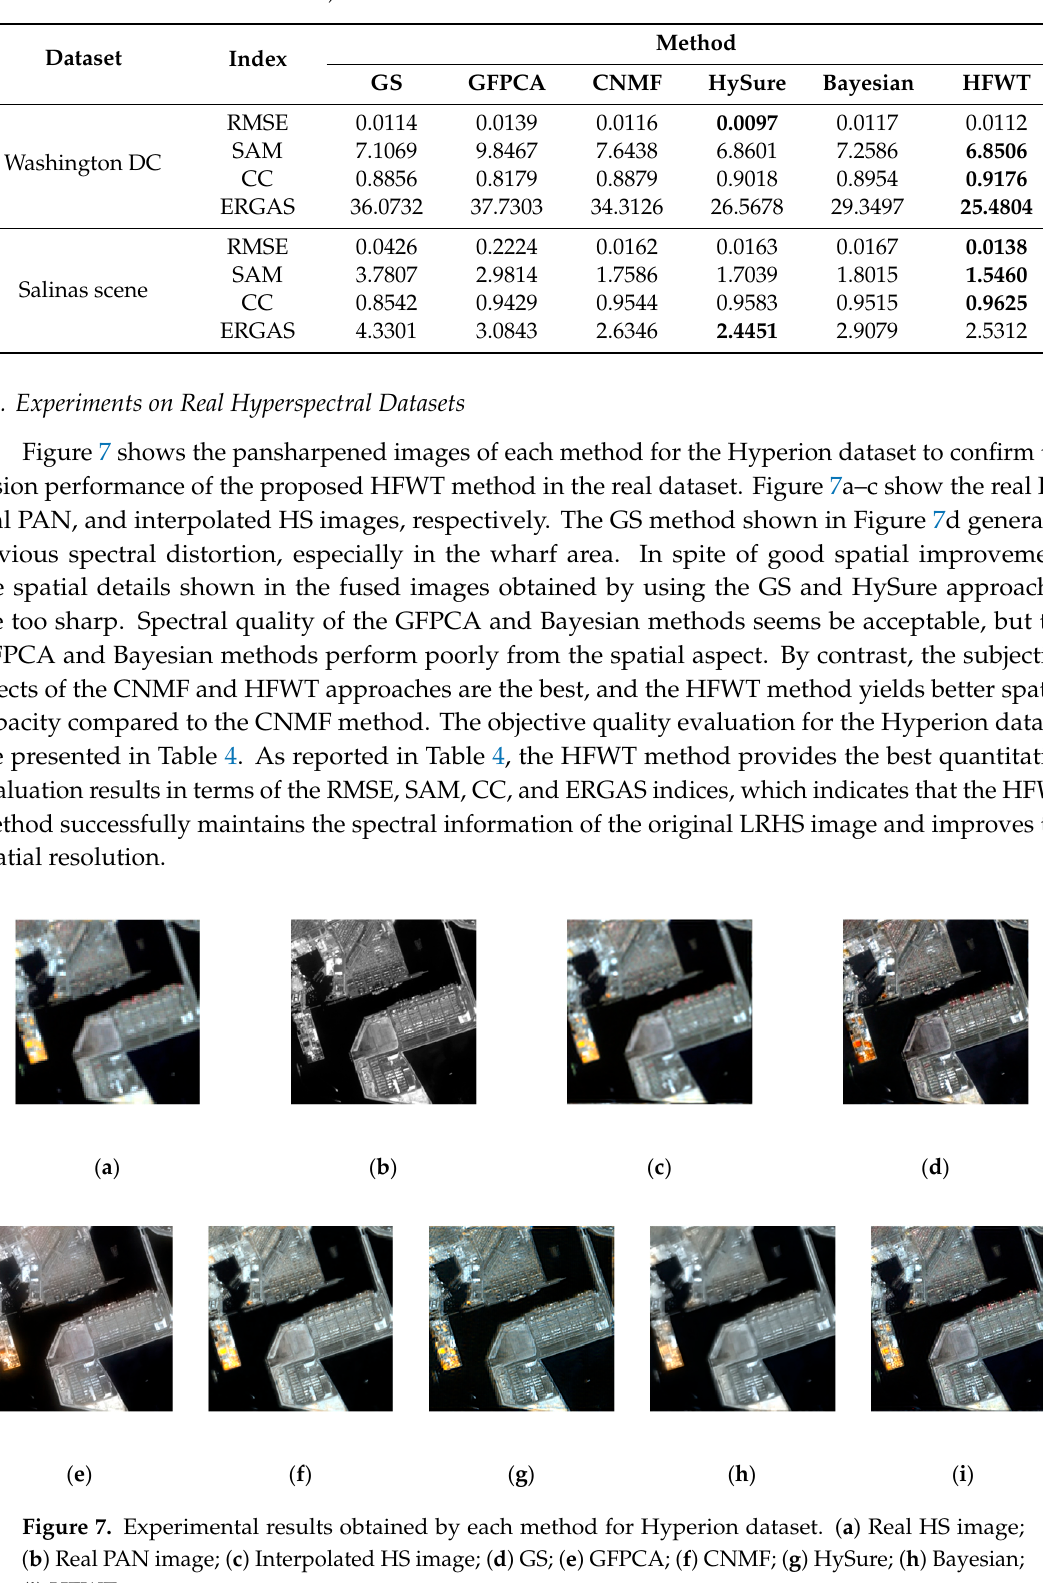
Table 3. Objective quality evaluation of each method for the simulated datasets. (The best values of each index are marked in bold.)